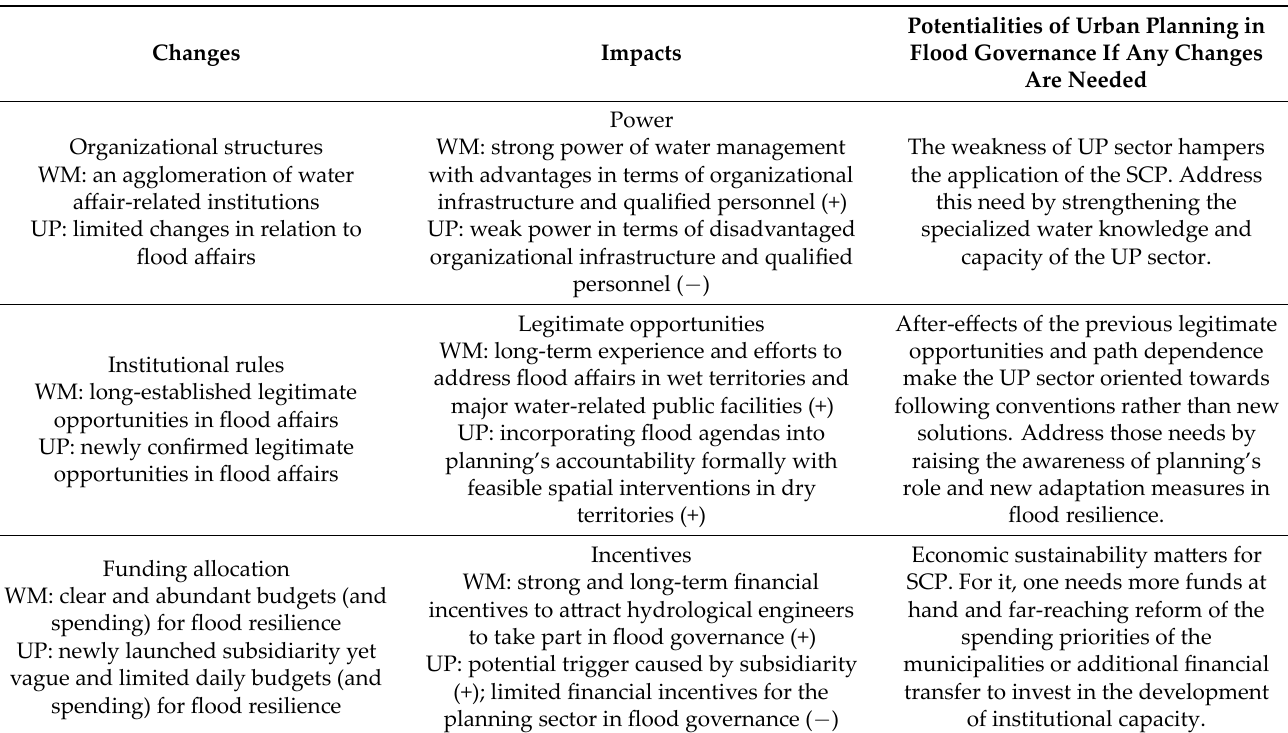
Table 2. Organizational structures, institutional rules, and funding allocation in flood